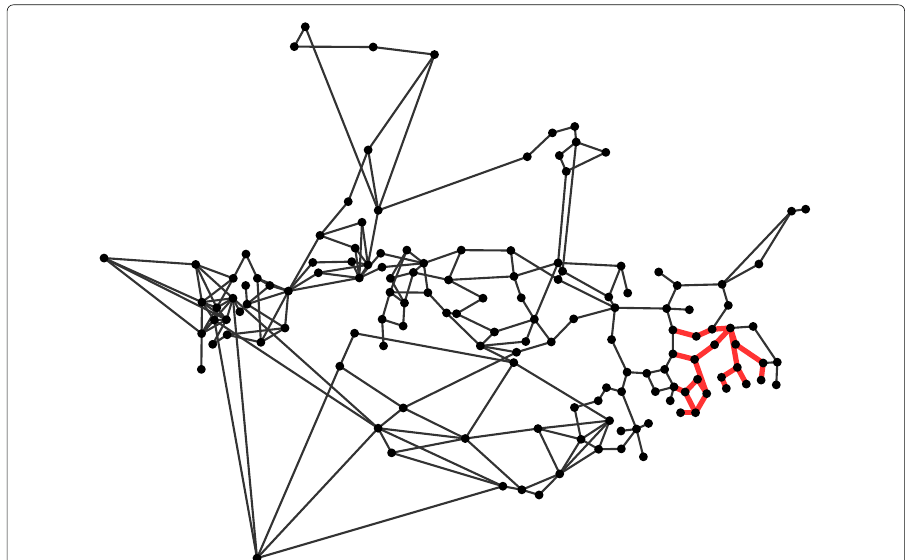
Fig. 7 Fault Locations Susceptible to CSI. Highlighted in red: the twenty most sensitive lines of the network, i.e. those where a fault is most likely to induce